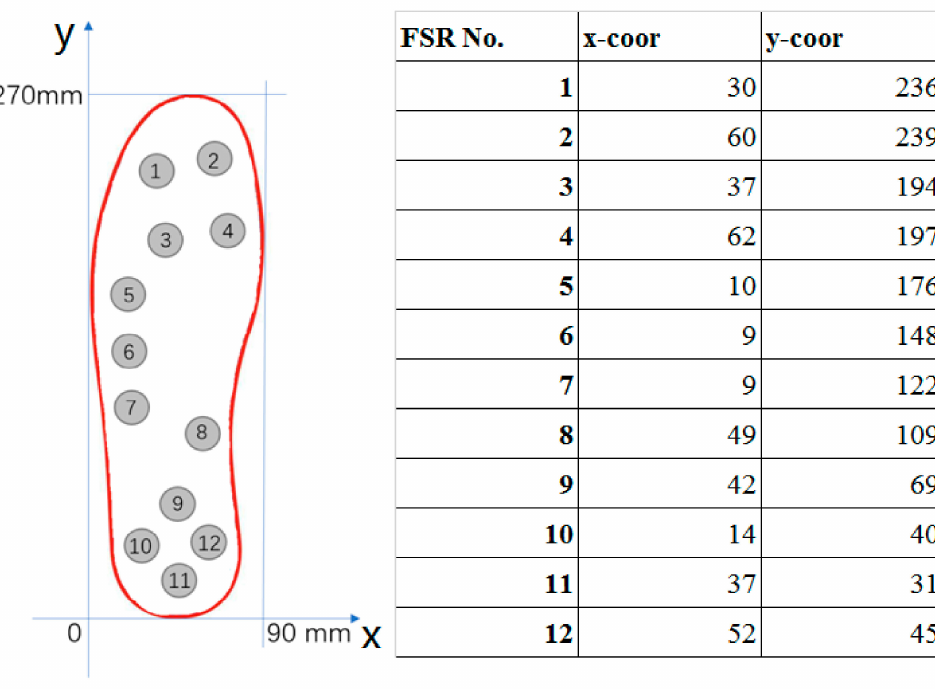
Figure 2. The layout of the 12 Force Sensitive Resistor (FSR) sensors and the corresponding